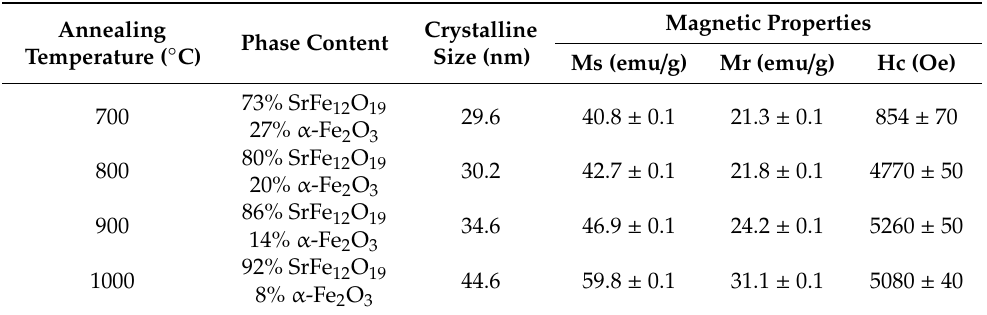
Table 2. Effect of annealing temperature on the phase content, crystalline size, and magnetic properties of the obtained SrFe 12 O 19 samples with an Fe/Sr molar ratio of 11.8.